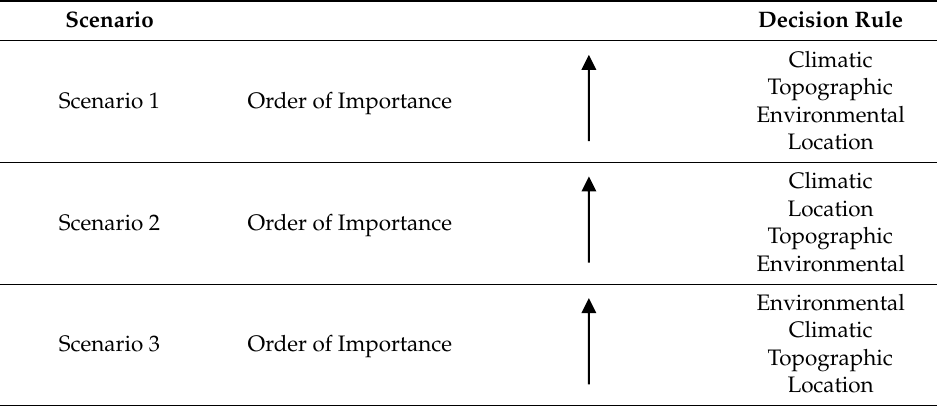
Table 5. Presentation of Decision Rules for each Study Scenario.